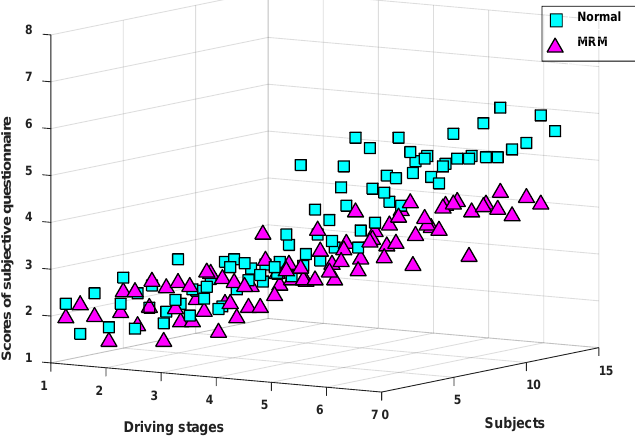
Figure 4. Subjective questionnaire (SQ) scores (mean ± standard deviation (SD)) for the 7 driving stages.